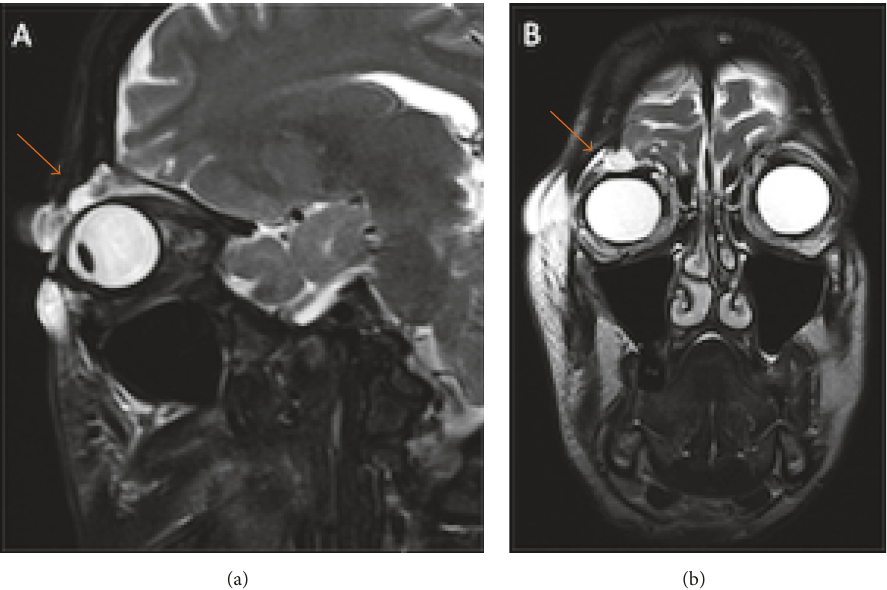
Figure 3: Orbital MR ((a) sagittal scan, (b) coronal scan) showed an area of bone discontinuity in the anterior right orbital roof with adjacent cephalocele (extraconic) and a frontobasal area of encephalomalacia related to